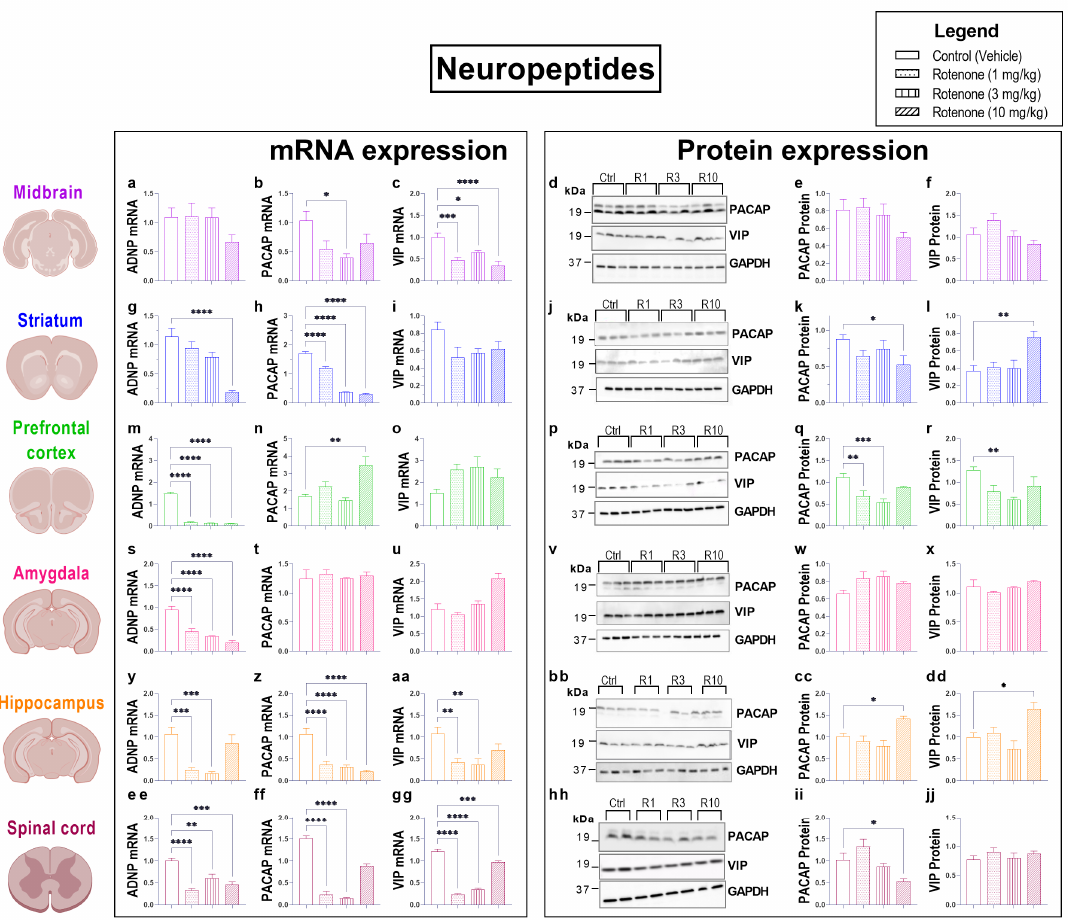
Figure 6. Rotenone disrupts the expression of neuropeptides in the CNS. Real-time qPCR analyses of ADNP, PACAP and VIP mRNA expression in the midbrain ( a – c ), striatum ( g – i ), prefrontal cortex ( m – o ), amygdala ( s – u ), hippocampus ( y – aa ) and spinal cord ( ee – gg ) of mice treated with either 1, 3 and 10 mg/kg rotenone i.p. for 21 days. Fold changes were calculated using the ∆∆ Ct method after normalization to s18 ribosomal protein subunit gene. Data represents means of n = 4 samples for each group. Western blot and densitometric analyses of PACAP and VIP protein expression in the midbrain ( d – f ), striatum ( j – l ), prefrontal cortex ( p – r ), amygdala ( v – x ), hippocampus ( bb – dd ) and spinal cord ( hh – jj ). Densitometric results are expressed as mean ± S.E.M of 4–6 samples per group. * p < 0.05, ** p < 0.01, *** p < 0.001 or **** p < 0.0001 as determined by one-way ANOVA followed by Dunnett’s post hoc test. Ctrl: control; R1, 3, 10: Rotenone (1, 3, 10 mg/kg); PACAP: pituitary adenylate cyclase-activating peptide; VIP: vasoactive intestinal peptide; ADNP: activity-dependent neurotrophic peptide; GAPDH: glyceraldehyde 3-phosphate dehydrogenase; kDa: